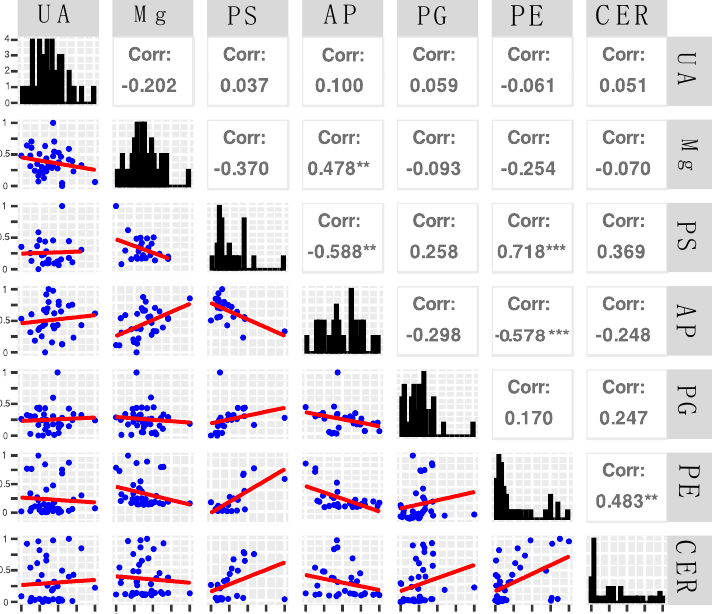
Figure 4. Correlation matrix and histogram between the metabolites, UA, and Mg 2+ . Abbreviations and legend: UA–uric acid; Mg 2+ –magnesium; phosphatidylserine 44:8 (PS), phosphatidylglycerol 36:6 (PG), phosphatidylethanolamine 36:4 (PE), arachidyl palmitoleate C36:1 (AP), and ceramide t18:0/22:0(2OH) (CER); Corr–Pearson correlation coefficient; ** p < 0.01; *** p < 0.001.